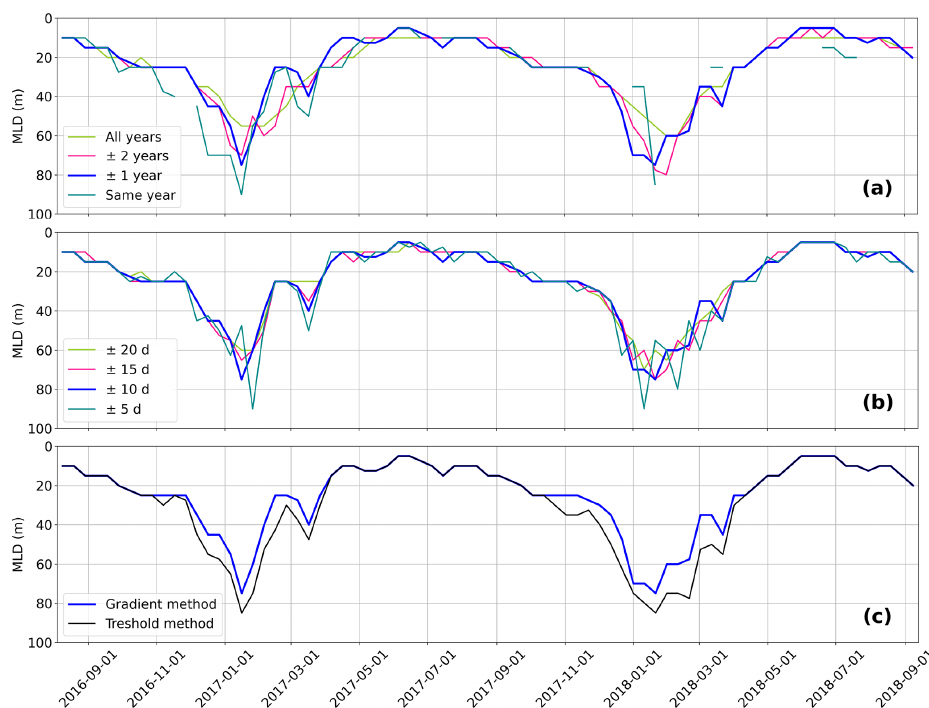
Figure A1. Sensitivity of the background MLD on the different parameters for events IER1–2 (see Table 1 and Fig. 10a): (a) (cid:49)y (year interval) and (b) (cid:49) day (day interval). (c) Sensitivity to the MLD computation method. The background MLD method used throughout this study is (cid:49) day = 10d, (cid:49)y = 1 year and the gradient method (common navy blue line on panels a–c